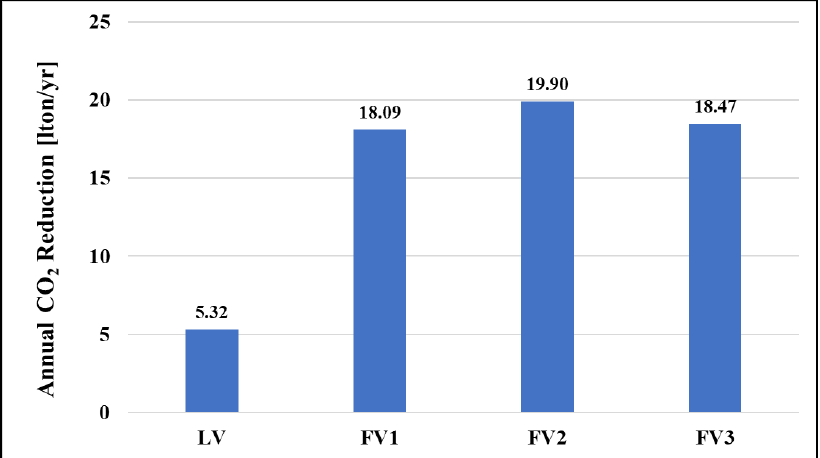
Figure 11. Annual CO 2 reduction in platooning vehicle driving compared to the single moving vehicle (SV) at a 0.5 L gap.